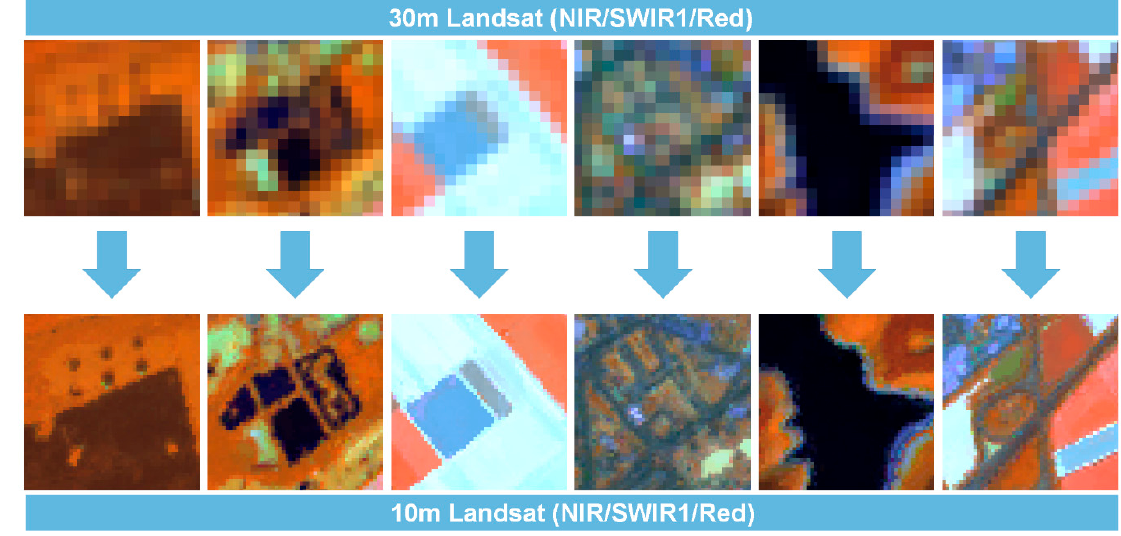
Figure 13. Landsat ARD at original 30 m resolution ( top ), and Landsat ARD with improved spatial resolution at 10 m ( bottom ) for image subsets from North Rhine Westphalia, Germany. Using the FORCE L2IMP module, the spatial resolution was enhanced using multi-temporal Sentinel-2 A/B prediction targets.